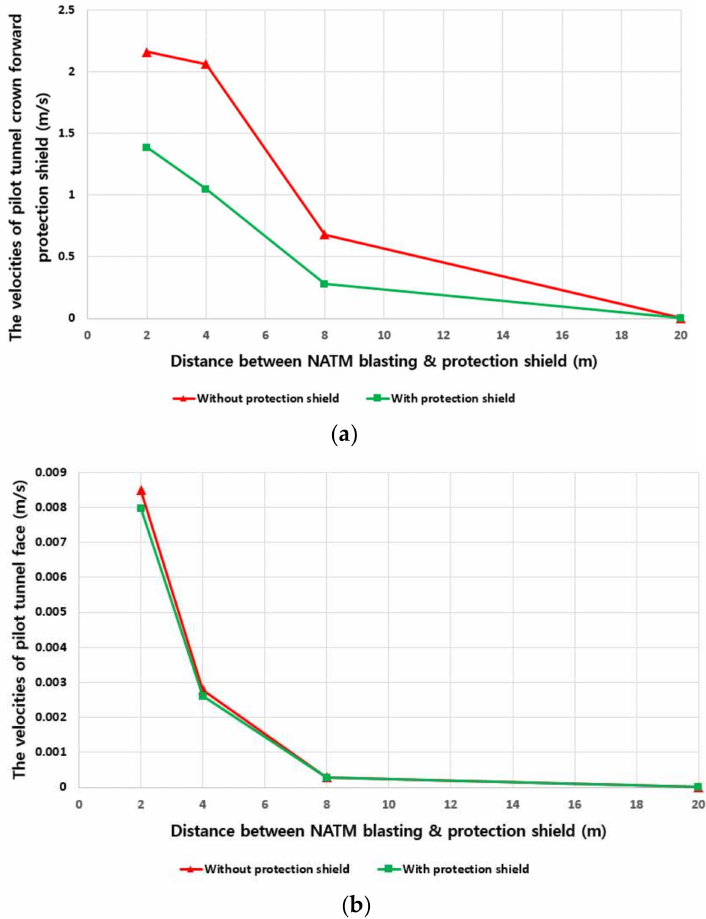
Figure 7. Numerical analysis result of vibration velocity at measurement points ( a ) A and ( b )